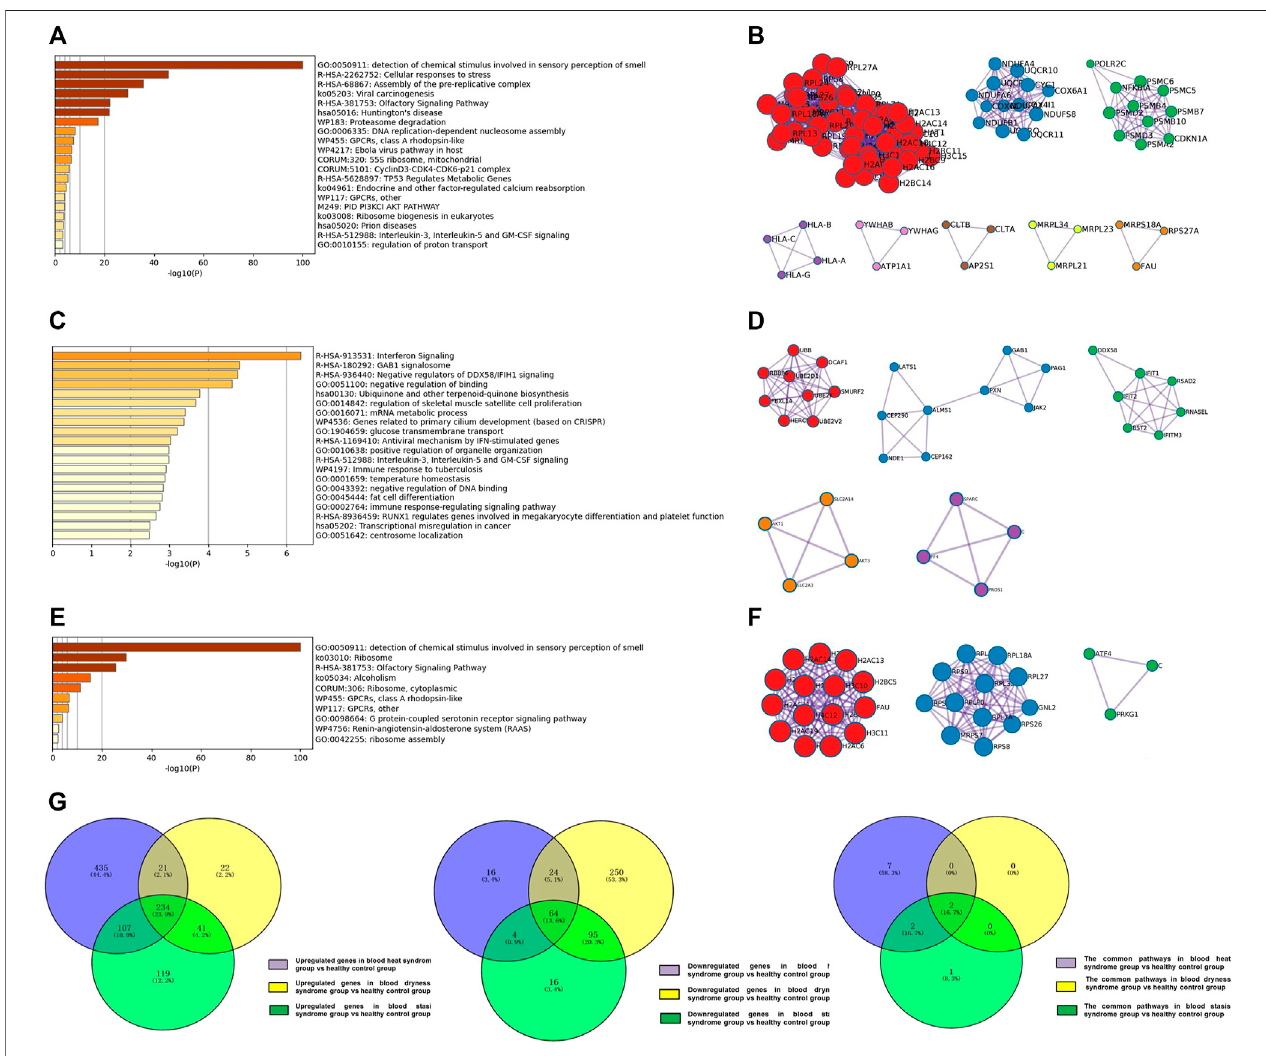
FIGURE 3 | Analysis of regulated differential genes and pathways between three syndromes of psoriasis and healthy control group. (A) Analysis of regulated differentialpathwaysbetweenthepsoriasisbloodheatsyndromegroupandthecontrolgroup; (B) Analysisofdifferentiallyexpressedgenesbetweenthepsoriasisblood heat syndrome group and the control groups; (C) Analysis of regulated differential pathways between the psoriasis blood dryness group and the control group; (D) Analysis of differentially expressed genes between the psoriasis blood dryness group and the control groups; (E) Analysis of regulated differential pathways between the psoriasis blood stasis syndrome group and the control group; (F) Analysis of differentially expressed genes between the psoriasis blood stasis syndrome and the control groups; (G) Venn analysis of differentially expressed genes and pathways between three syndromes of psoriasis and healthy control group.